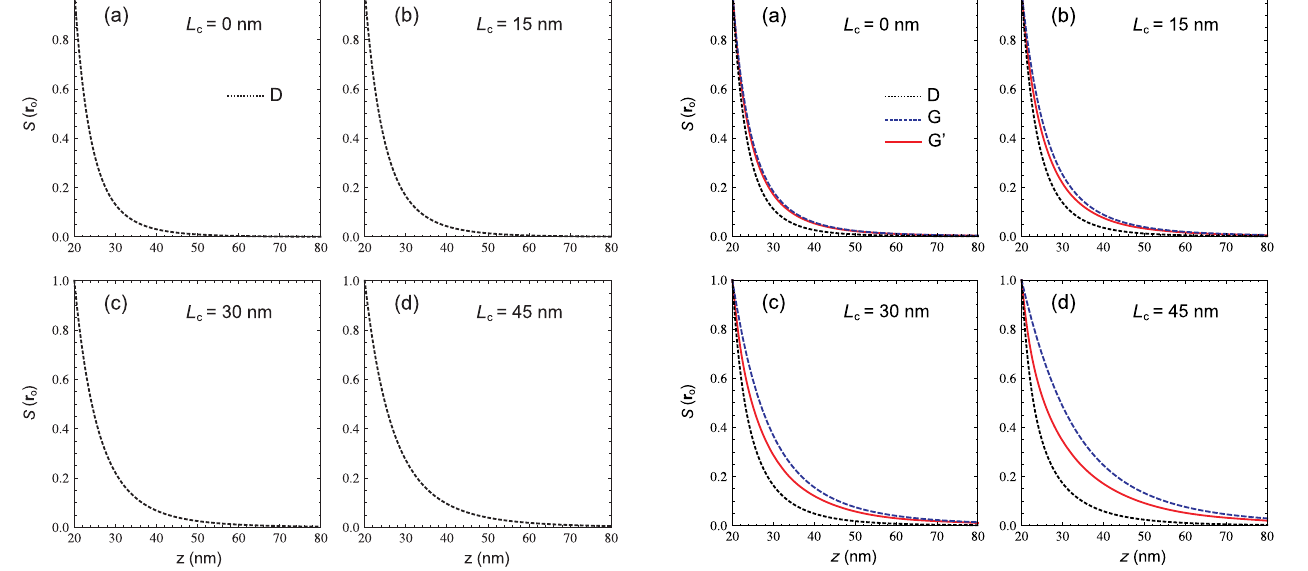
~ f 3 and r 15 nm. The e ¼ tip ¼ 20 min ¼